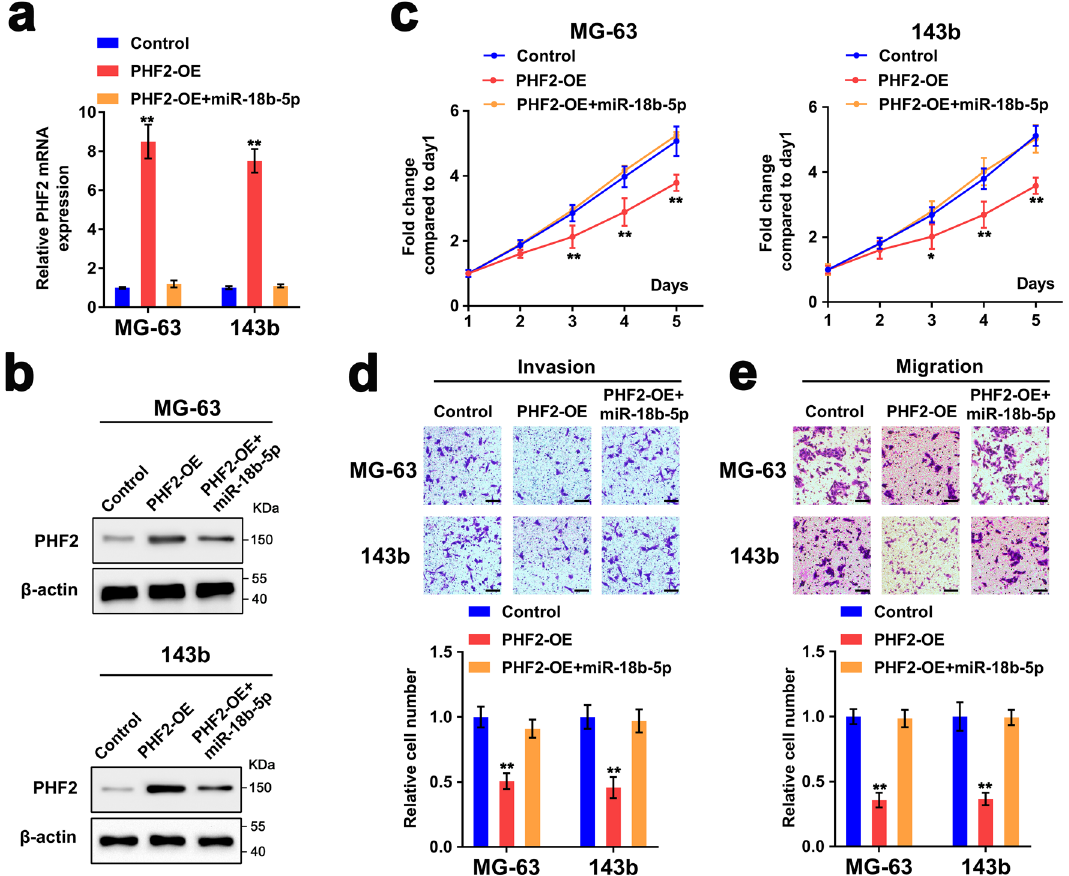
Figure 4. PHF2 is responsible for miR-18b-5p-mediated cell proliferation, invasion and migration. ( a , b ) RT-qPCR and western blotting results showed the mRNA and protein expression of PHF2 in MG-63/143b cells transfected with PHF2 overexpression plasmid, miR-18b-5p mimic or negative control. ( c – e ) The proliferation, invasion and migration of MG-63/143b cells, transfected with PHF2 overexpression plasmid, miR-18b-5p mimic or negative control, was evaluated by the MTT and transwell assays. Scale bar = 100